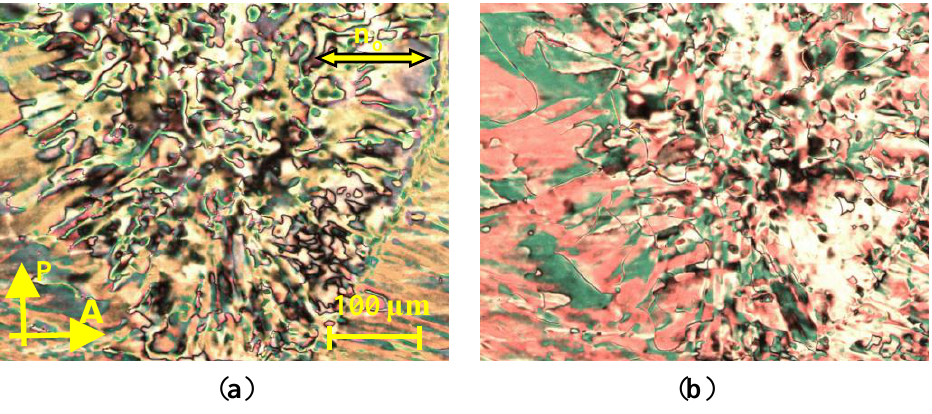
Figure 2. Textures of the nematic phase of 1 between untreated glasses observed between crossed polarizers. ( a ) N phase at 25 °C; (b) N phase at 50 °C.